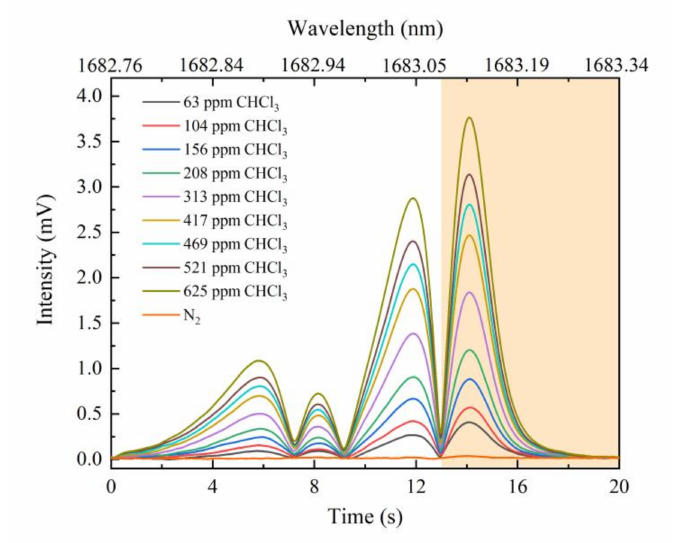
Figure 4. 1f PA signal of different concentrations of chloroform gas. Nine different concentrations of chloroform gas together with pure nitrogen were measured in the experiment and the pure nitrogen signal was regarded as the base signal (colored area is the selected effective